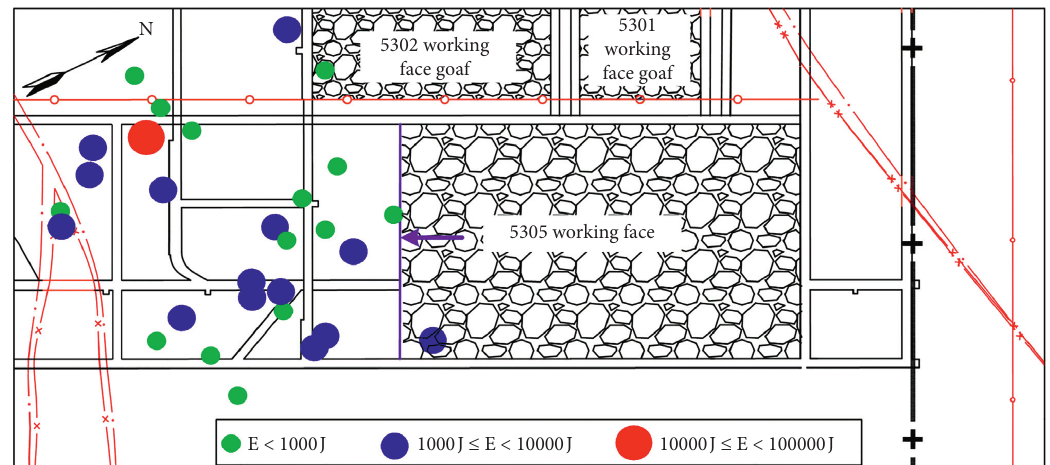
Figure 4: Plane distribution of microseismic events during the rock burst appearance.